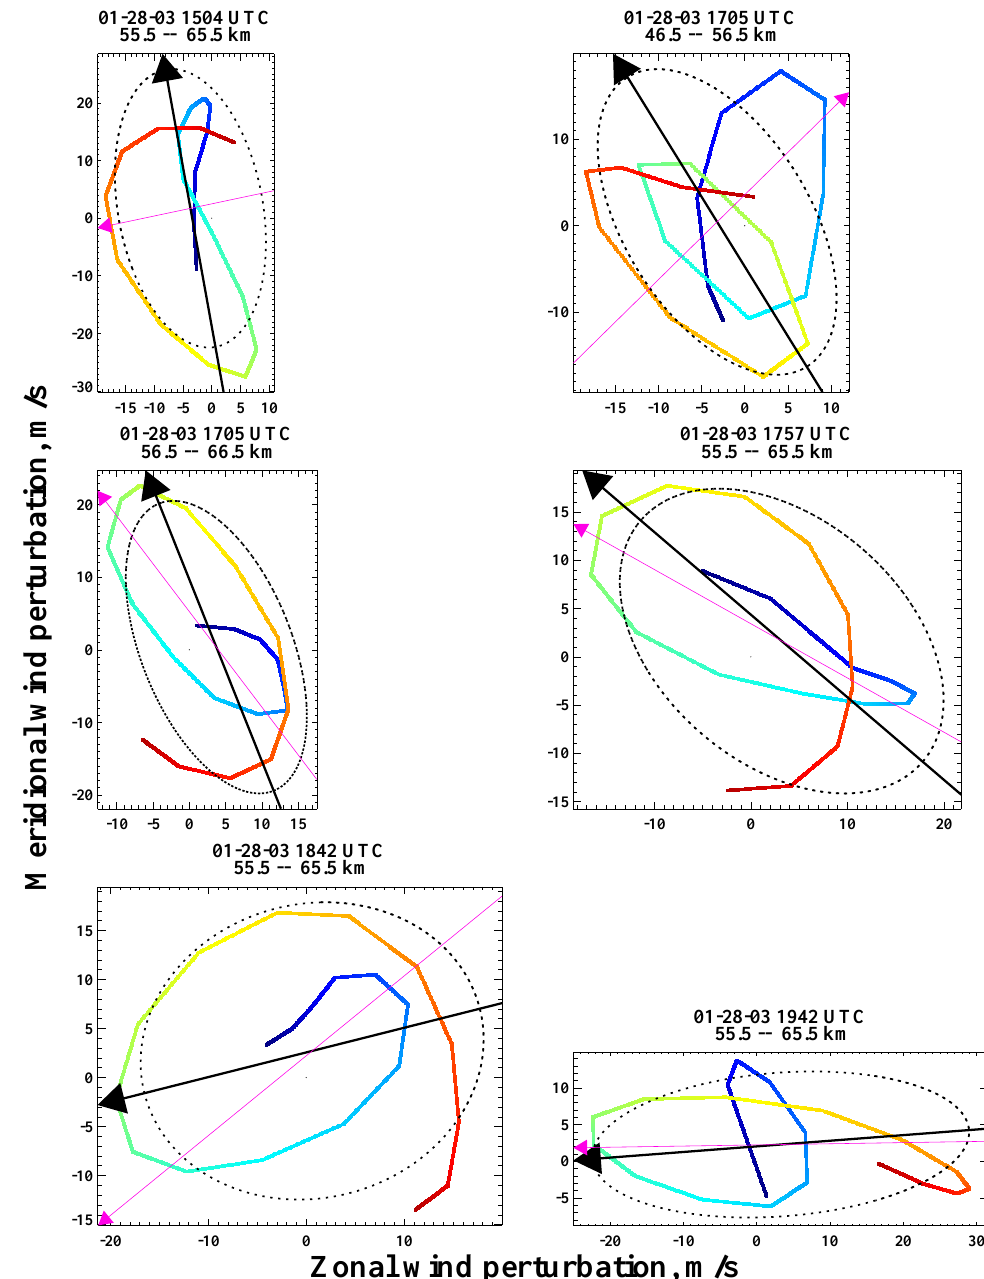
Fig. 8. Similar to Fig. 7 but for FS Salvo 2 at 60km and above.